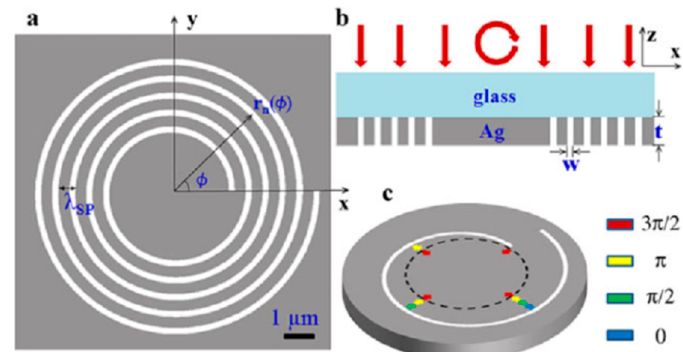
Figure 5. ( a ) Schematic diagram of left-handed multiple-turn plasmonic lens; ( b ) RCP light at a wavelength of 660 nm illuminates along the negative z -coordinate ( c ) schematic diagram of the relative phase of surface plasmon waves excited by the spiral slit under RCP illumination. The different color arrows represent the different phases’ increment of the electric field E z . Reproduced with permission from [44]. Copyright Springer, 2011.